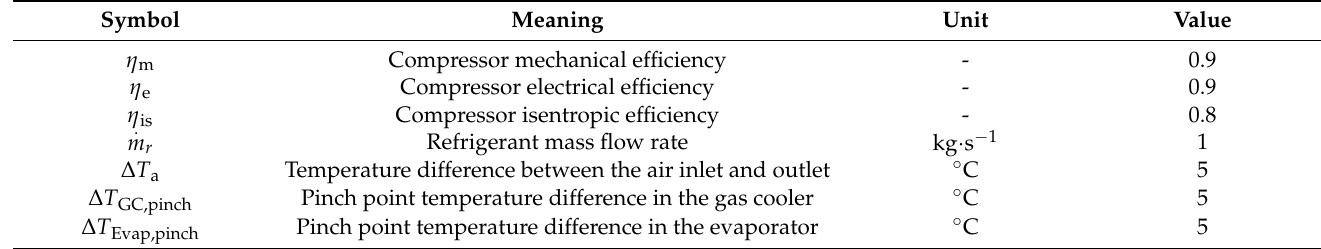
Table 2. The assumptions used in the energy